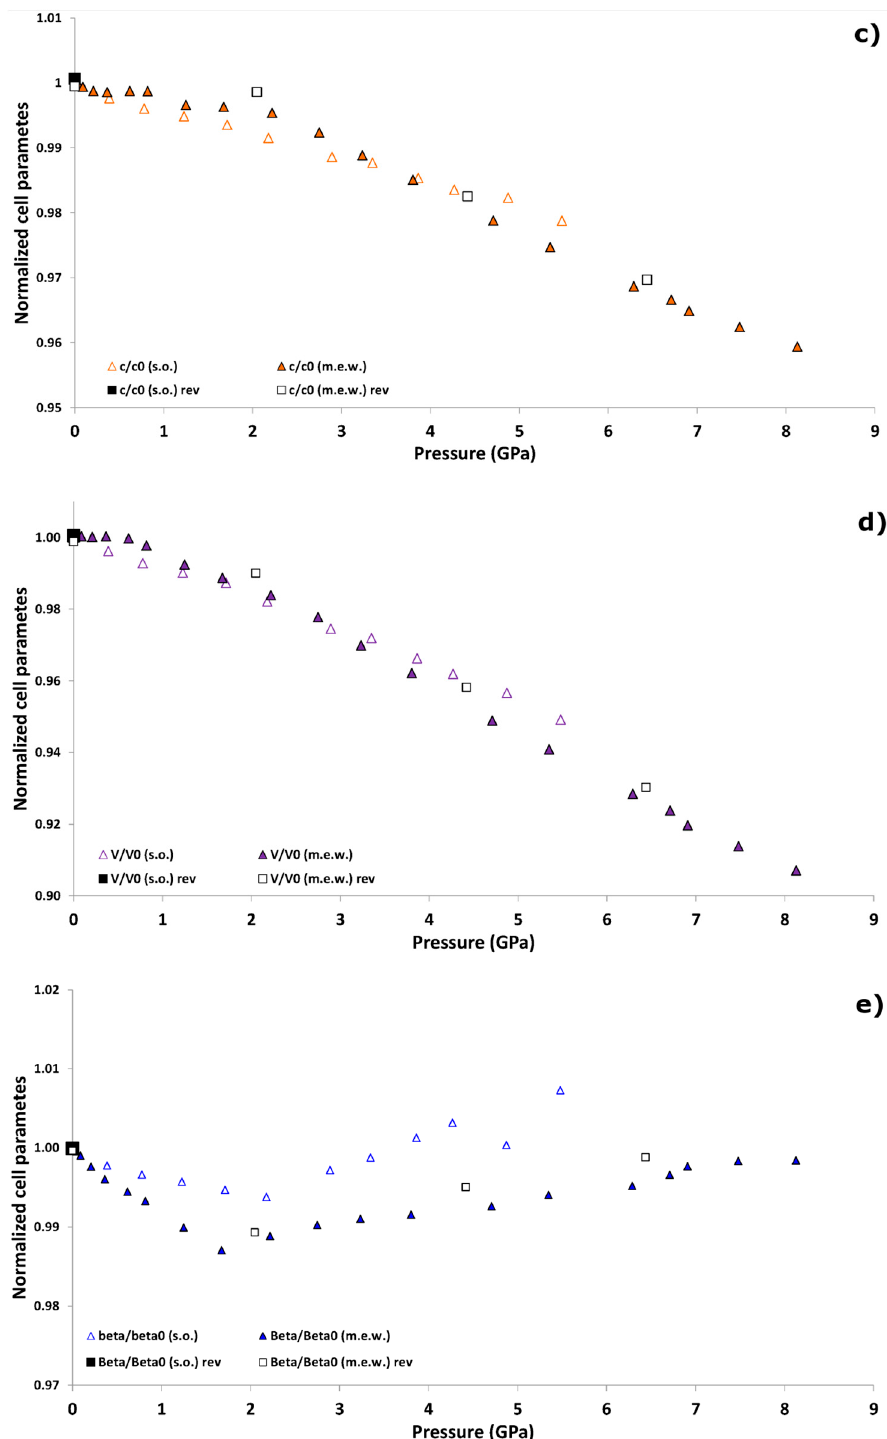
Figure 4. Variation of amicite normalized lattice parameters ( a ) a/a0 ; ( b ) b/b0 ; ( c ) c/c0 ; ( d ) V/V0 ; ( e ) β / β 0 as a function of pressure in silicone oil and (16:3:1) methanol-ethanol-water. The errors associated with the cell parameters are smaller than the symbol size.